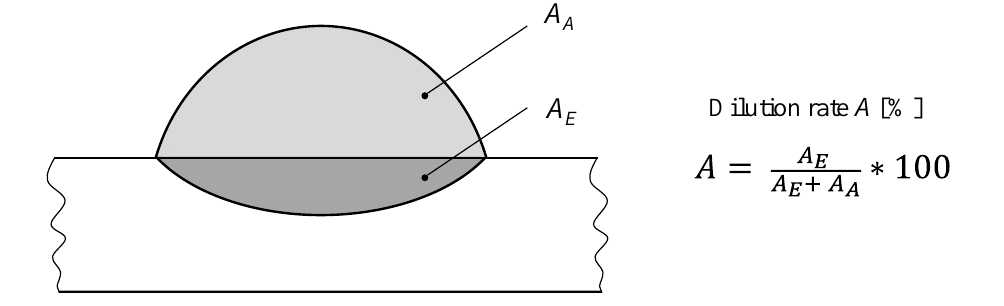
Figure 2. Definition of the dilution rate A .